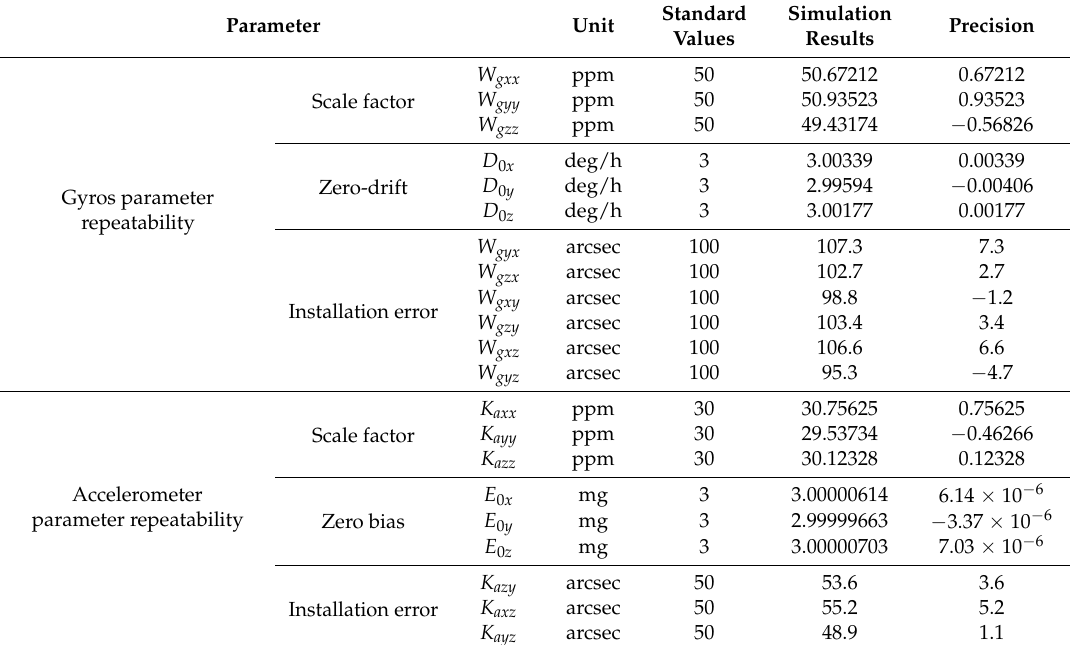
Table 2. Simulation experimental